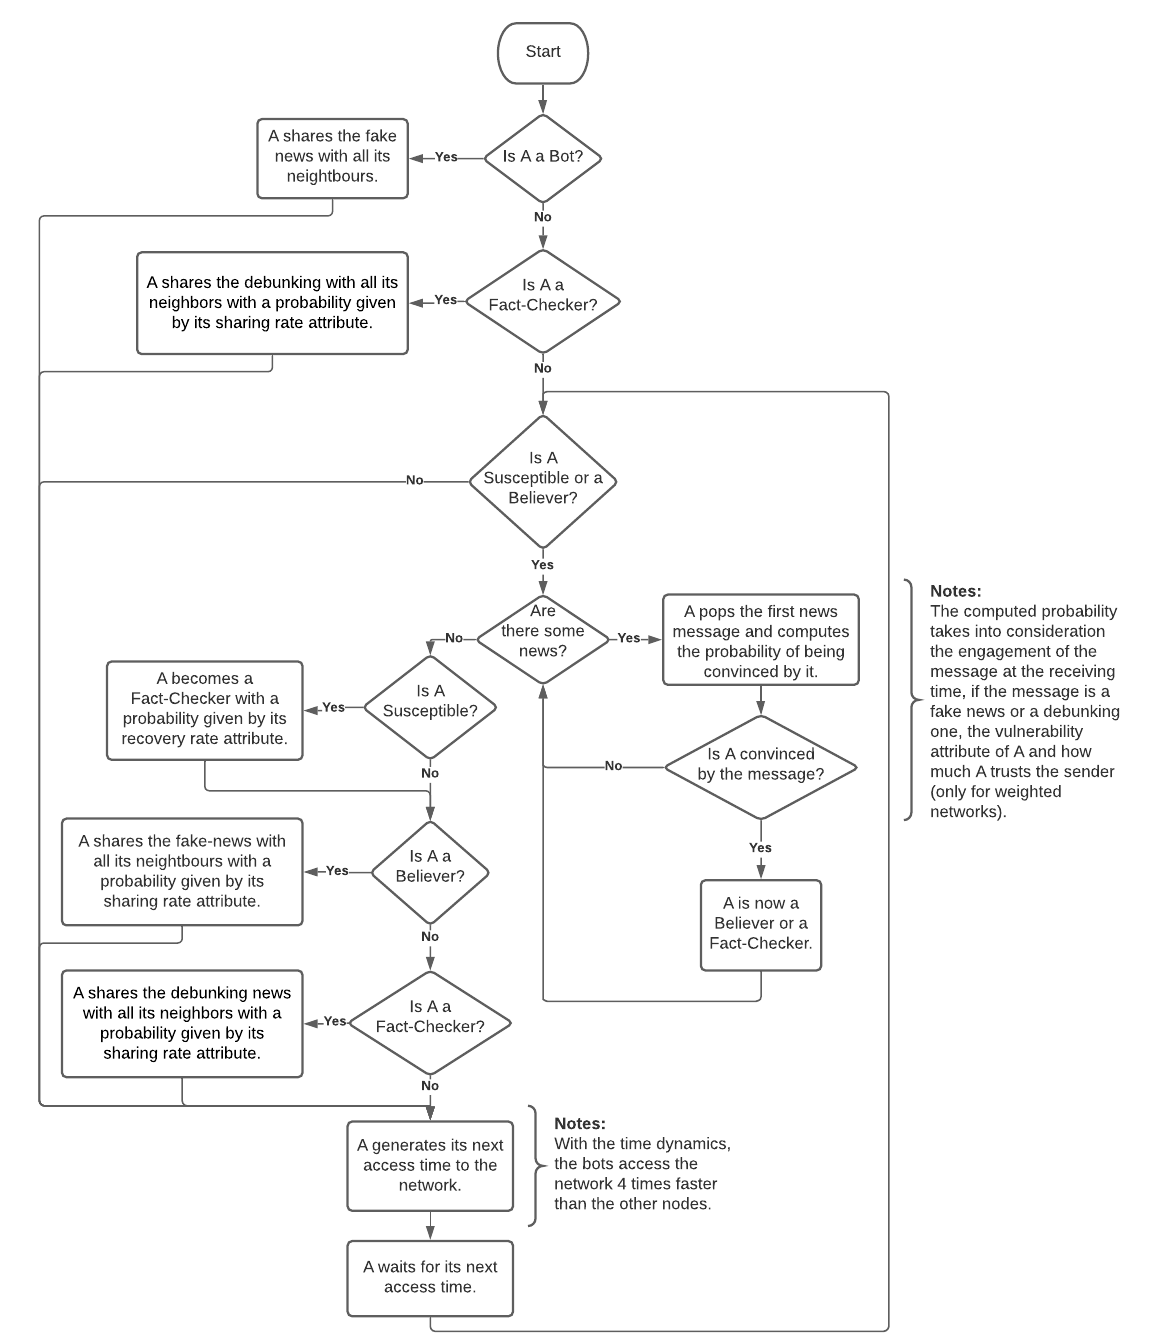
Figure 4. Diagrammatic representation of our fake news epidemic simulation